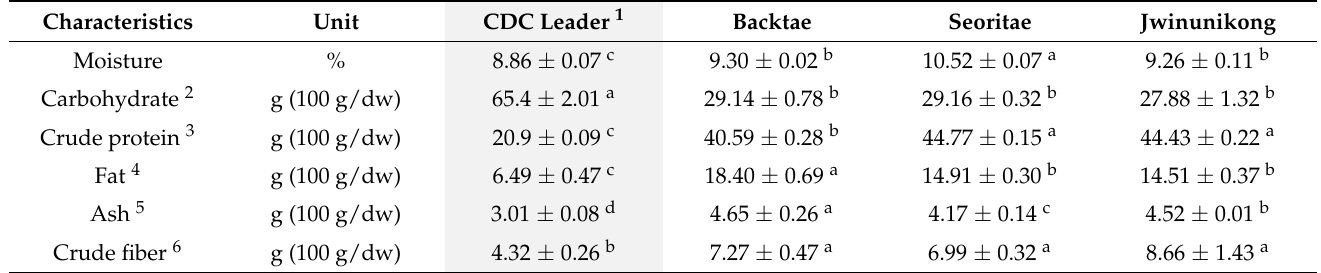
Table 2. Characteristics of the dried seeds.